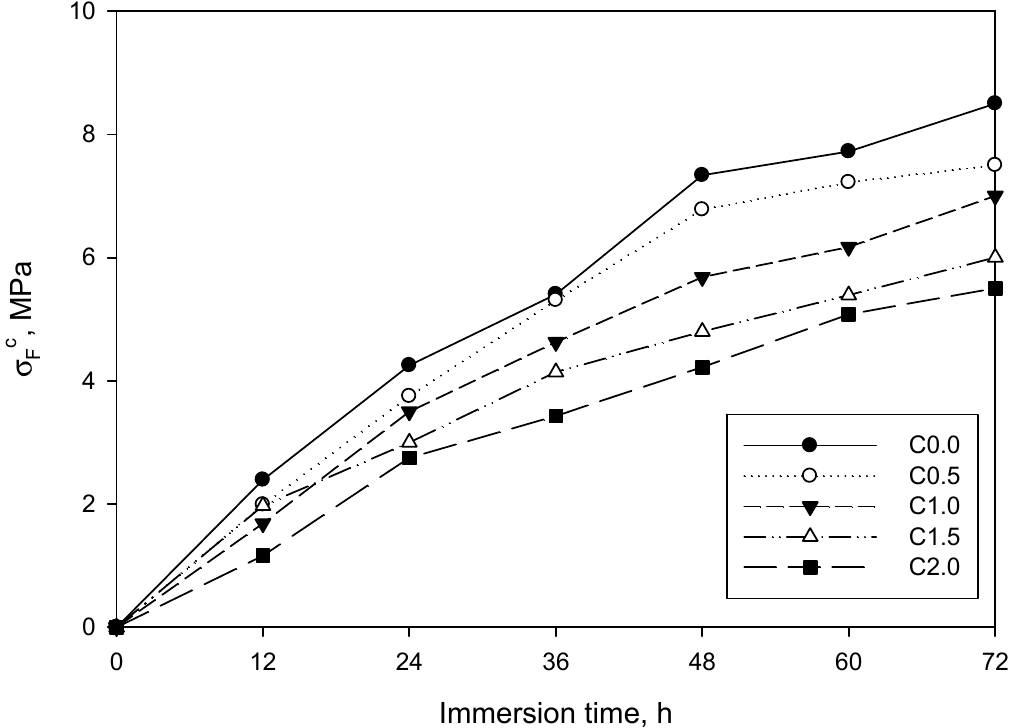
Figure 7. Relative flexural strength loss as a function of immersion time. Values refer to the non-immersed samples.